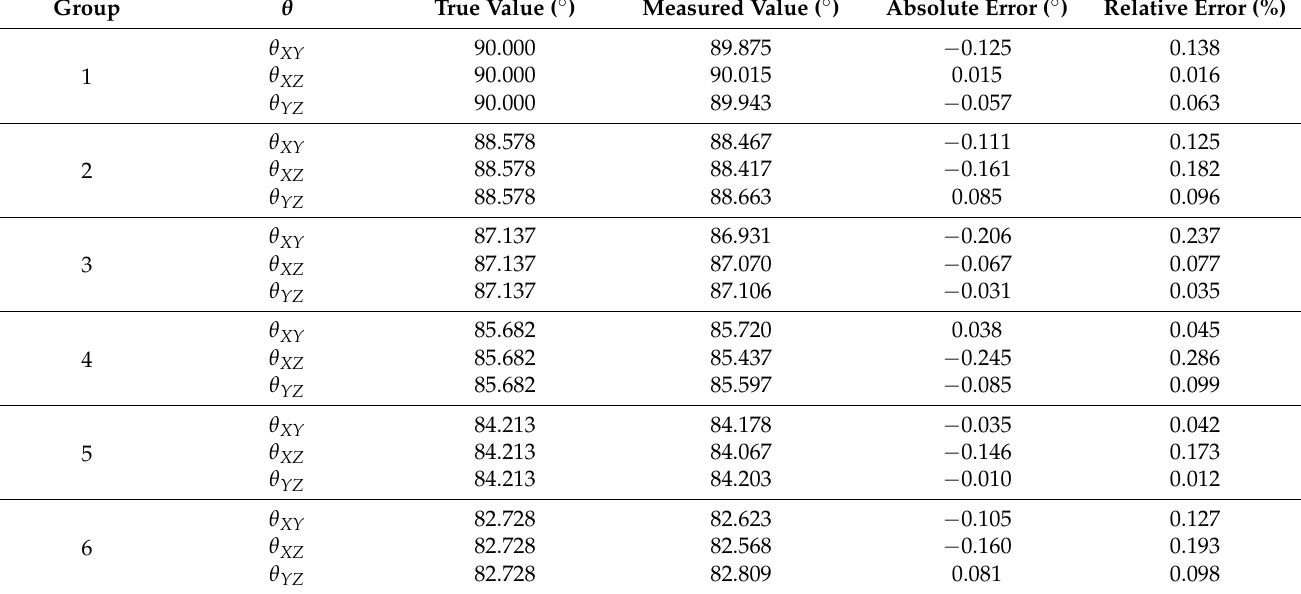
Table 4. The results of angle measurement between moving trajectories.